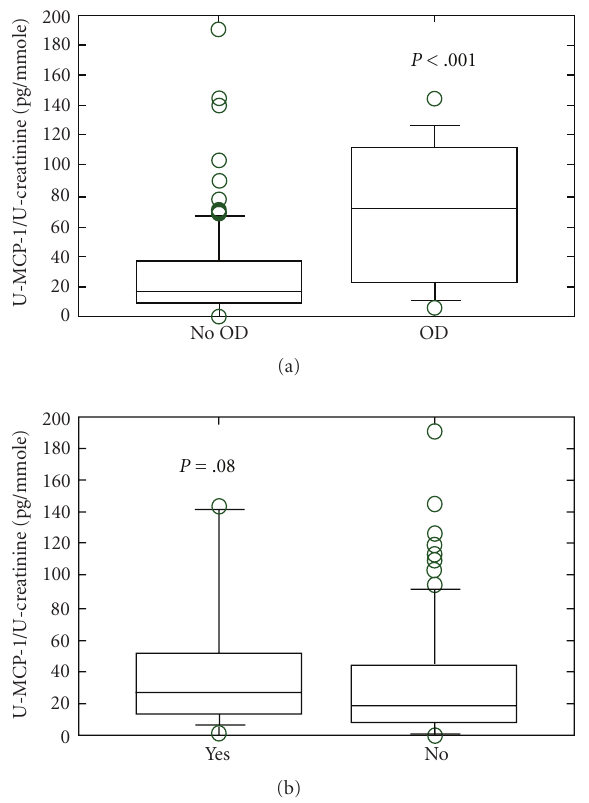
Figure 1: (a) U-MCP-1 as prognostic marker No OD: no devel- opment of critical damage according to VDI during followup. OD: development of critical damage according to VDI. All patients